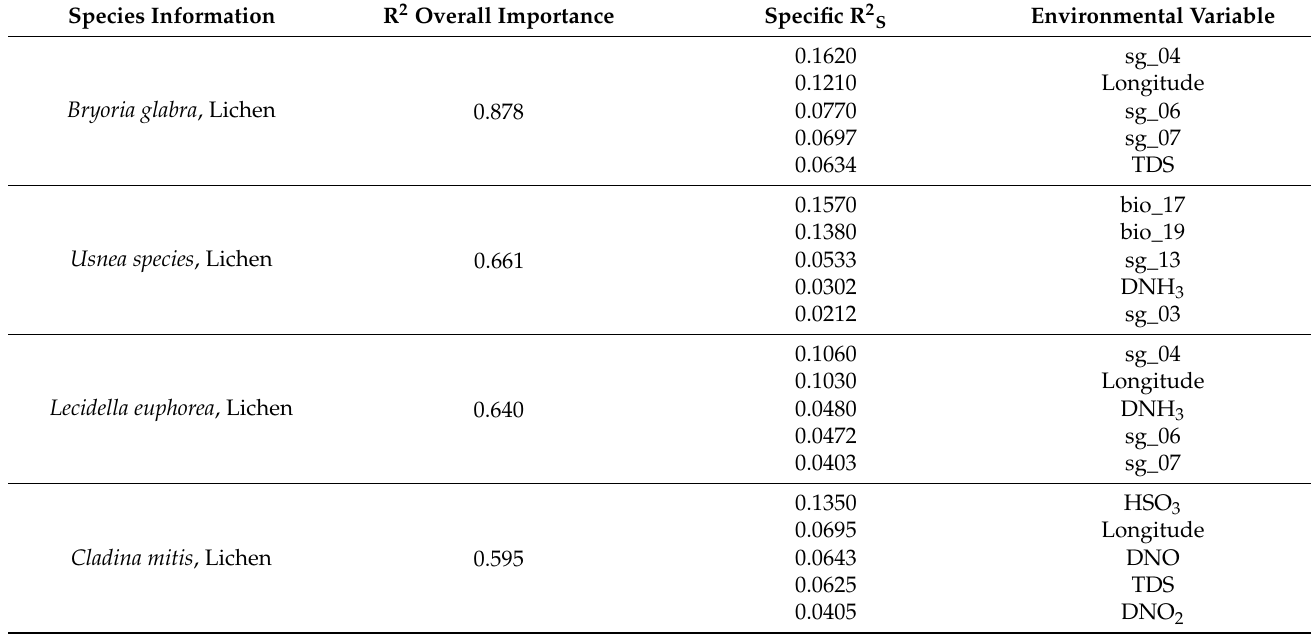
Table 3. R 2 overall importance, the sum of R 2 S performance values for all environmental variables across a given species, for top 13 species (R 2 > 0.4). Specific R 2 performance values (R 2 S ) for the top five environmental variables associated to each